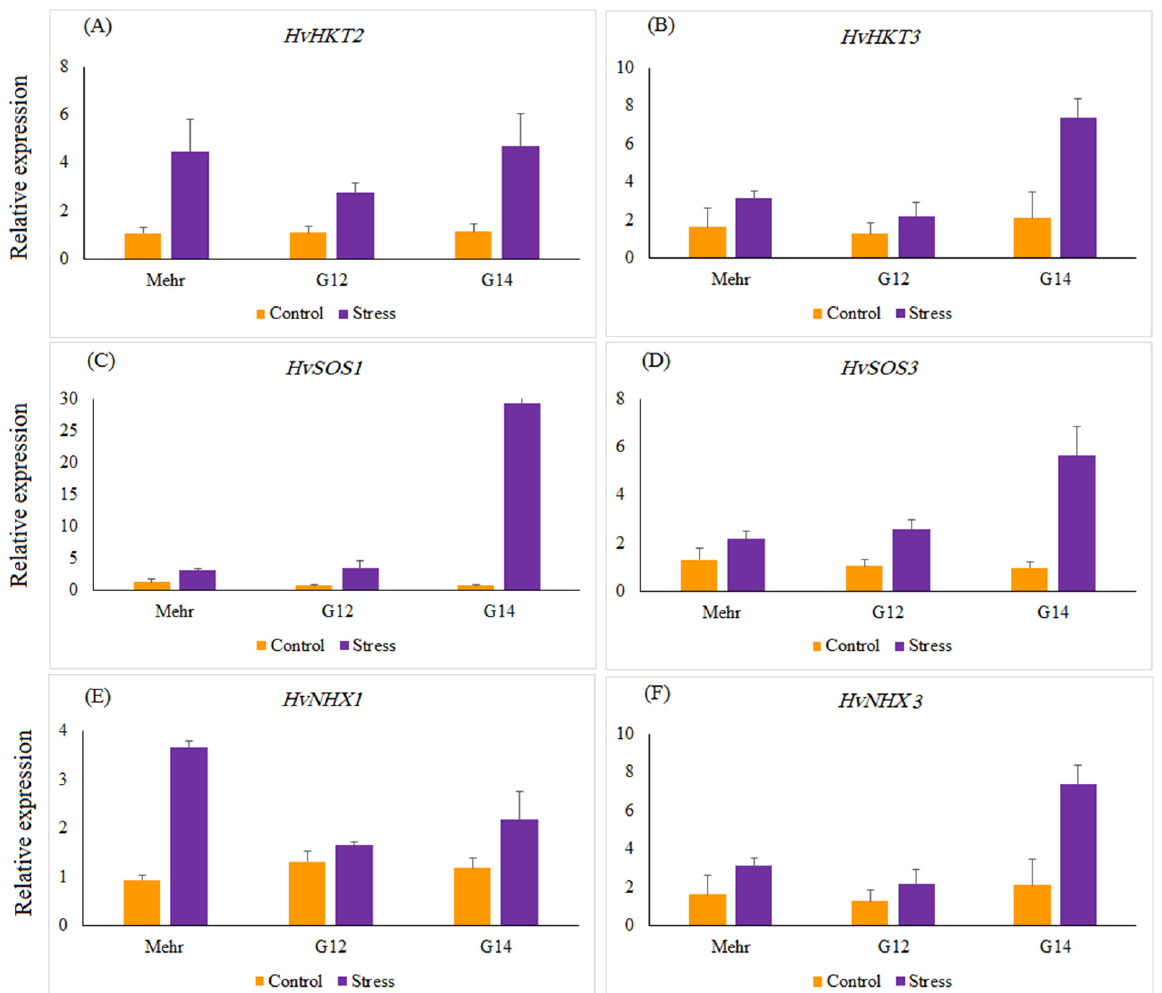
Figure 3. The relative expression patterns of (A) HvHKT2 , (B) HvHKT3 , (C) HvSOS1 , (D) HvSOS3 , (E) HvNHX1 , (F) HvNHX3 genes in selected barley genotypes under the control and salinity stress conditions. The two-way interaction between treatment and genotype main effects for all studied genes are significant at p < 0.01.